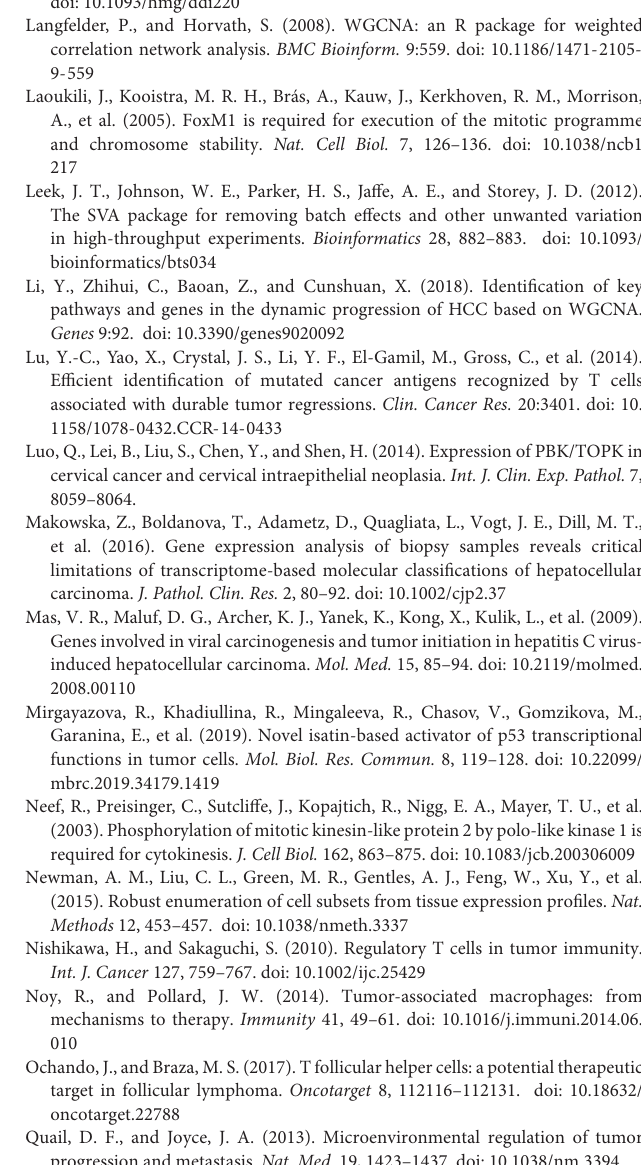
Supplementary Figure 1 | Flowchart detailing the overall study design and samples at each stage of analysis. Supplementary Table 1 | Information for the seven GEO datasets included in the current study. Supplementary Table 2 | MEs related to HCC. Supplementary Table 3 | Top 40 genes from protein-protein network ranked by 12 different algorithms of cytohubba including Degree, DMNC, EPC, MCC, MNC, Bottleneck, Closeness, EcCentricity, Radiality, Betweenness, Stress and Clustering Coefficient. Supplementary Table 4 | The correlation between survival-related candidate genes and immune cells. Spearman’s Rho and p -values were calculated using the online web resource TIMER